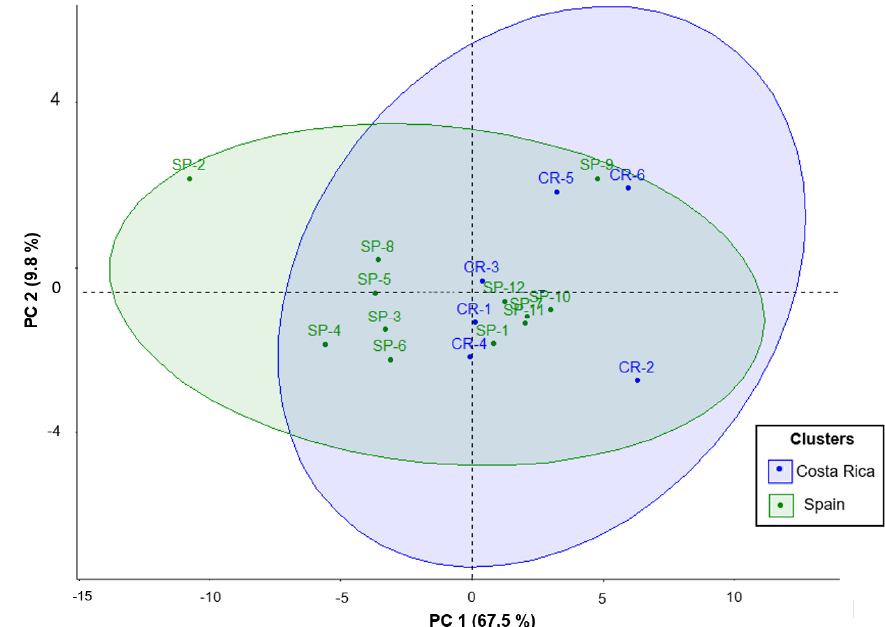
Figure 6. Plane defined by two first principal components (PC1 and PC2) resulting from the PCA analysis of individualized phenolic composition of U. tomentosa commercial products ( n = 18). Origin: CR—Costa Rica, and SP—Spain.